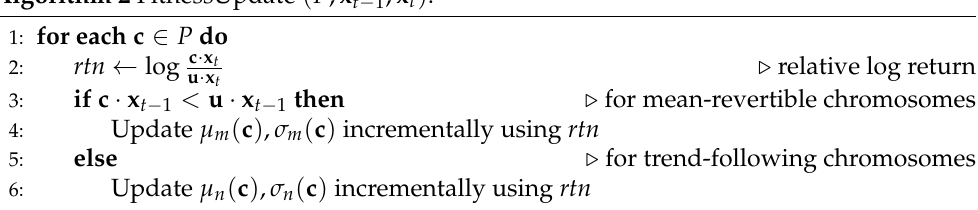
Algorithm 2 FitnessUpdate ( P , x t − 1 , x t )